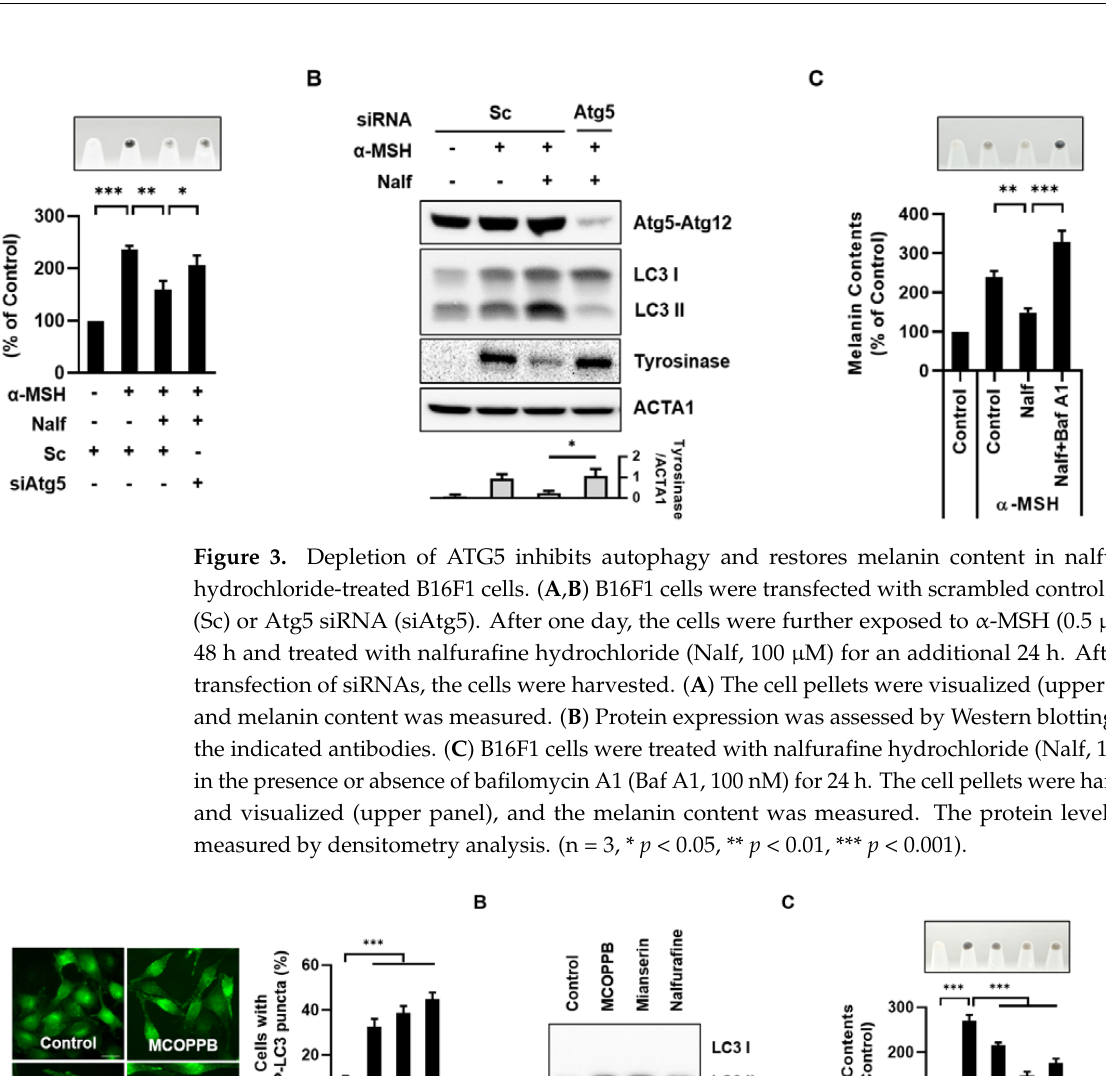
lation of the κ -opioid receptor influences melanophagy activation in B16F1 cells.